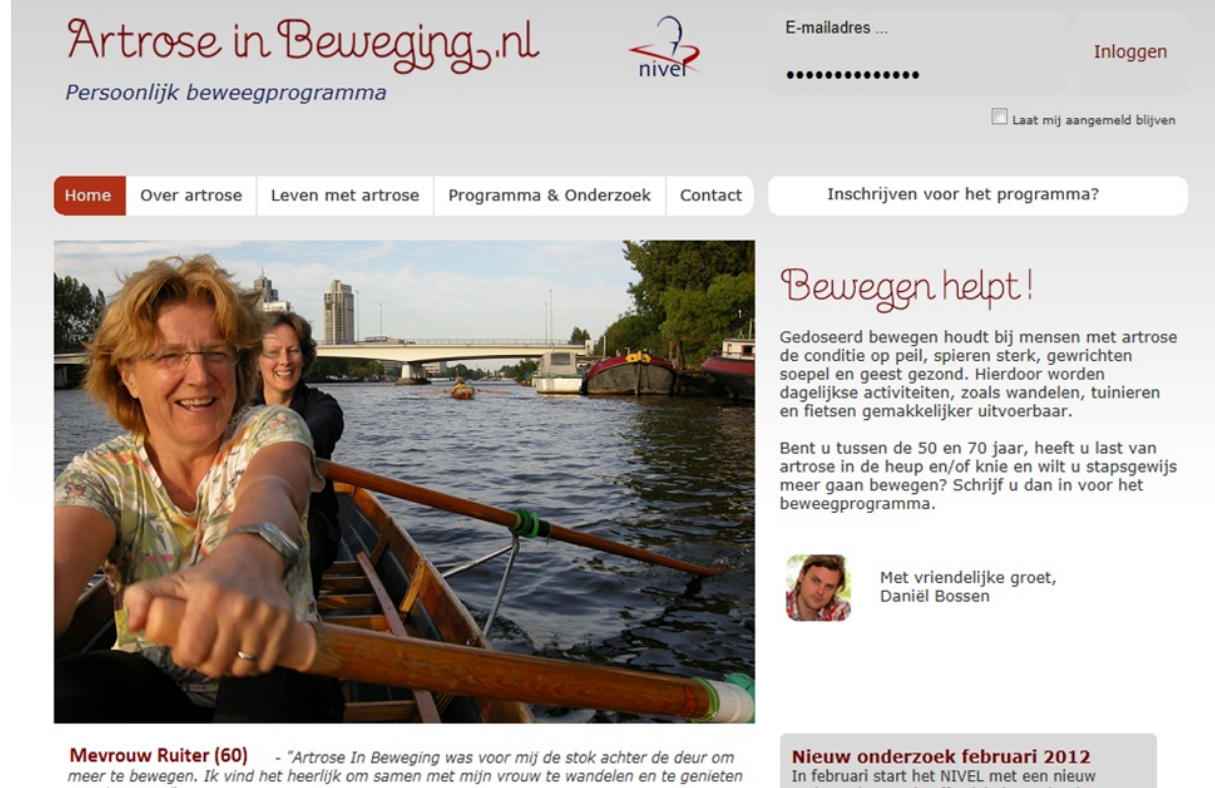
Figure 1. Join2move